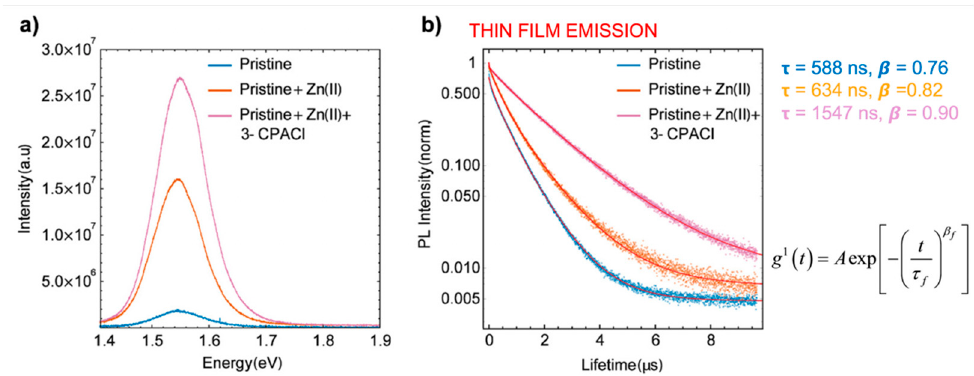
Figure 11. Characterization of MA / FA film with and without Cl − and Zn(II) dopants. ( a ) Relative yield of emission by time-integrated photoluminescence (PL) spectra. ( b ) Time-dependent PL traces with different dopants, stretched exponential fitting with function. Reproduced with permission from ACS Appl. Mater. Interfaces 2019 , 11 , 17555–17562 . Reference [41].